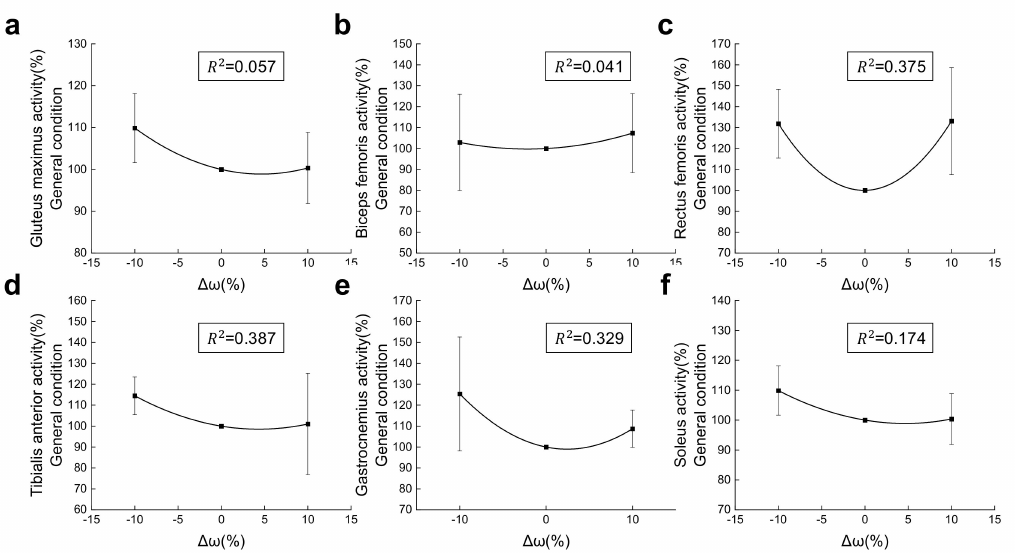
Figure 11. Mean and standard deviation of the muscle activity (as a percentage of the value for walking at the preferred step frequency) for the last two minutes of walking across the three different frequencies under the general condition. Step frequencies are plotted as the percentage difference from the preferred frequency, ∆ ω . The preferred frequency is ∆ ω = 0%. The solid line represents the quadratic curve with error bars of standard deviation. Each subplot is a different muscle under the general condition: ( a ) gastrocnemius muscle; ( b ) biceps femoris muscle; ( c ) rectus femoris muscle; ( d ) tibialis anterior muscle; ( e ) gastrocnemius muscle; ( f ) soleus muscle.